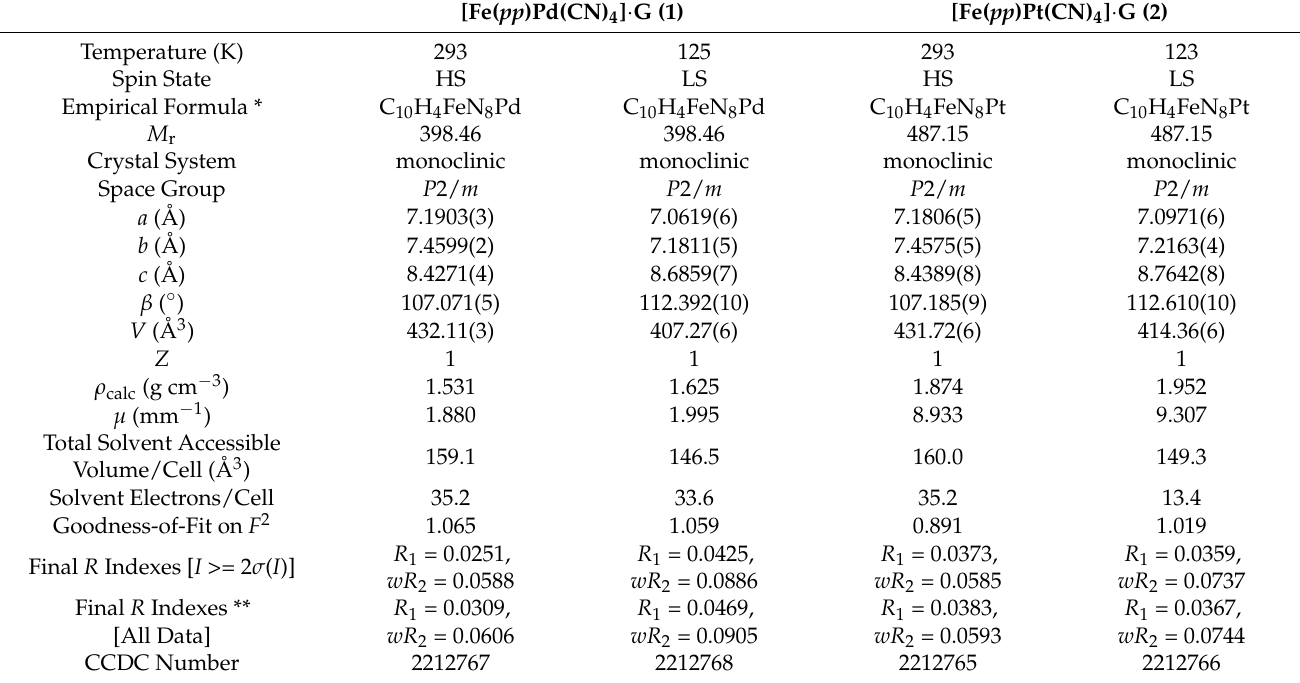
Table 1. Crystallographic data for 1 and 2 in the LS and HS states.